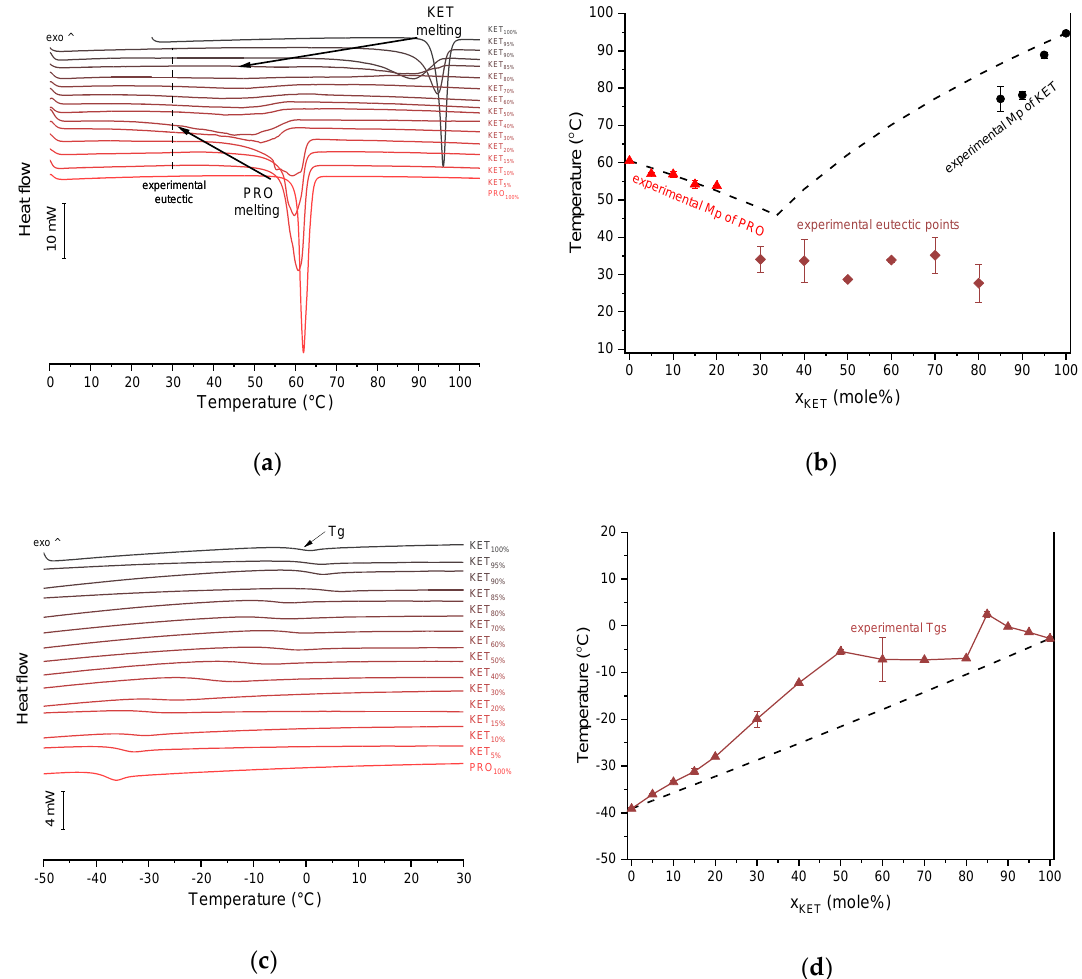
Figure 2. Thermal analysis of KET-PRO systems: ( a ) DSC thermograms from first heating; the broken line indicates the position of the eutectic peak while the arrows show the position of the melting peaks, ( b ) phase diagram based on thermal analysis of first DSC heating; the broken lines show the theoretical liquidus curves calculated using Equation (1), ( c ) DSC thermograms from second heating (the samples were first heated to 110 ◦ C at 10 ◦ C / min, quench cooled at a nominal cooling rate of 300 ◦ C / min and reheated at 10 ◦ C / min) ( d ) phase diagram based on thermal analysis of second DSC heating; the broken line shows the theoretical Tg values calculated using Equation (2). For plots (a) and (c) the subscript indicates the content of the named component in